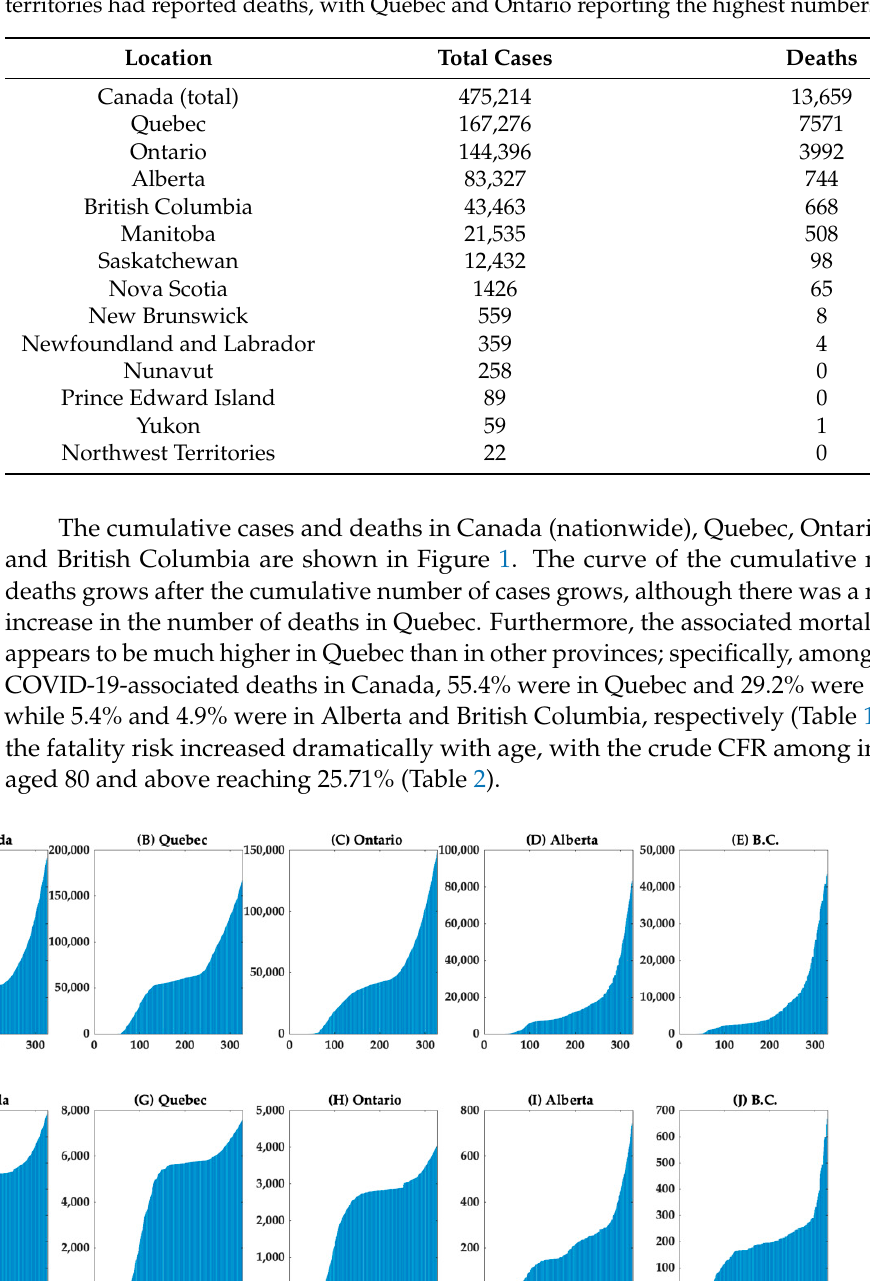
Table 1. Number of confirmed COVID-19 cases and deaths in Canada as of 15 December 2020, by province or territory. As of 15 December 2020, there had been 475,214 confirmed cases and 13,659 deaths attributed to COVID-19 in Canada, with confirmed cases in all provinces and territories; Quebec had reported the highest number of confirmed cases. Ten of Canada’s 13 provinces and territories had reported deaths, with Quebec and Ontario reporting the highest numbers.